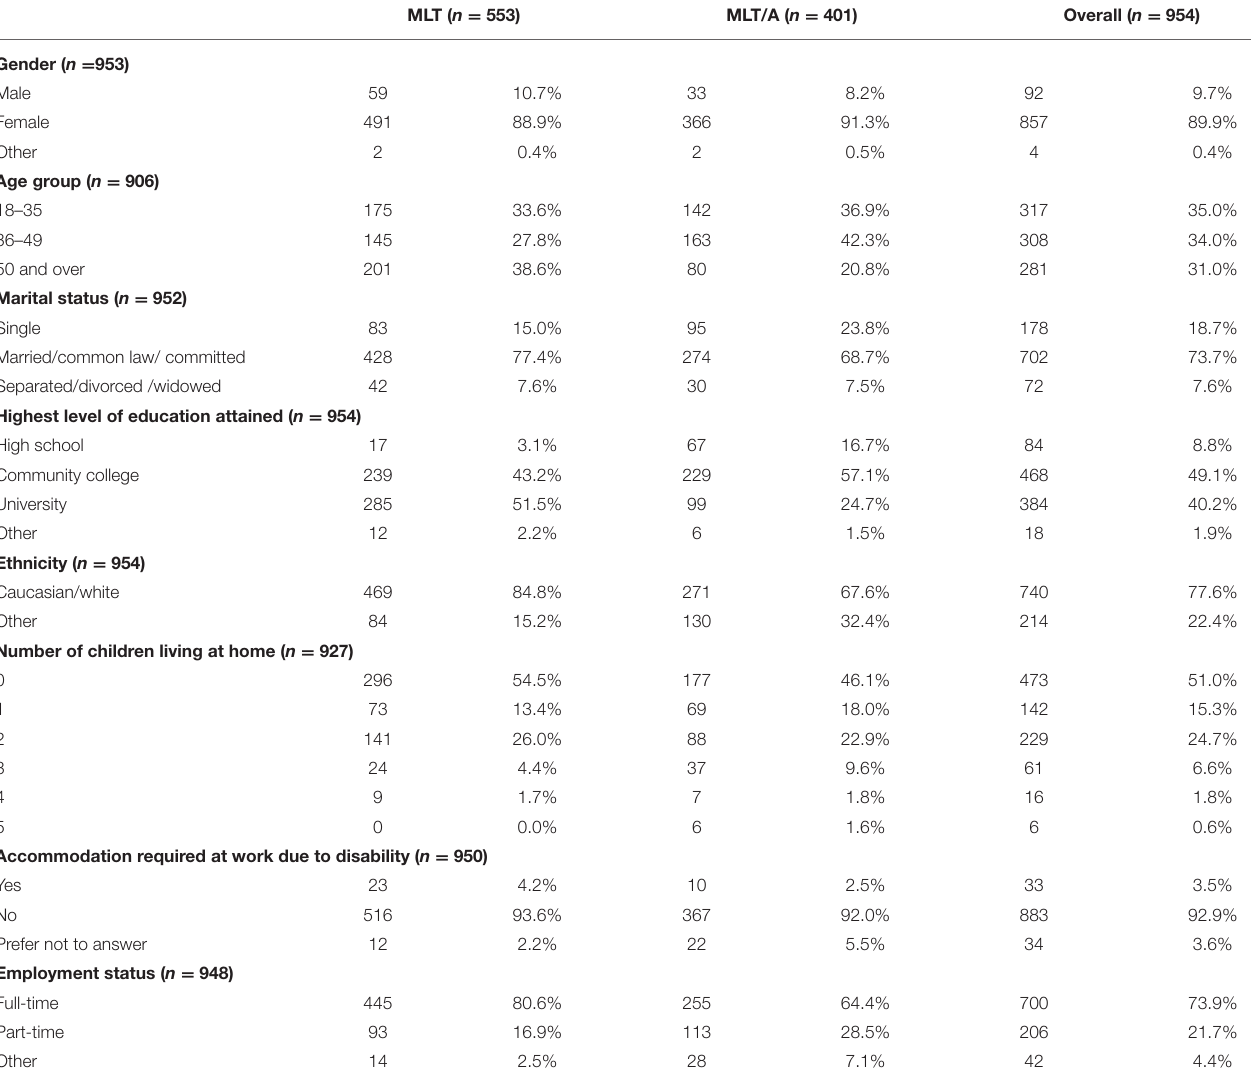
TABLE 1 | Demographic and occupational characteristics of MLT and MLT/A